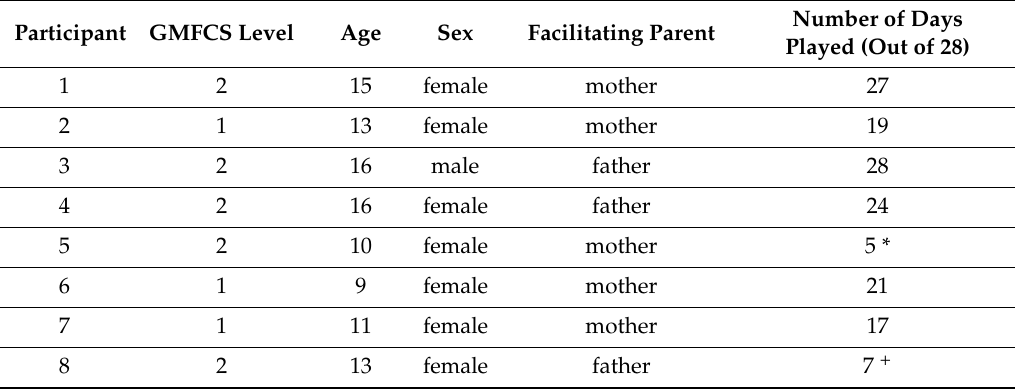
Table 2. PedBotHome participant